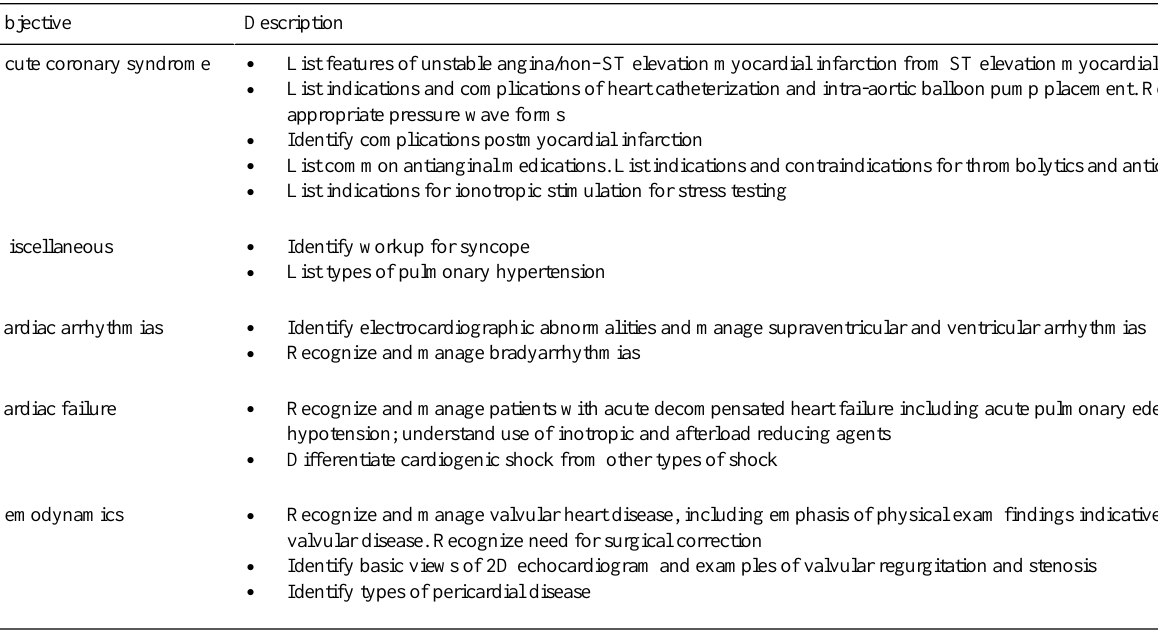
Table 1. Krannert Cardiology Handbook app